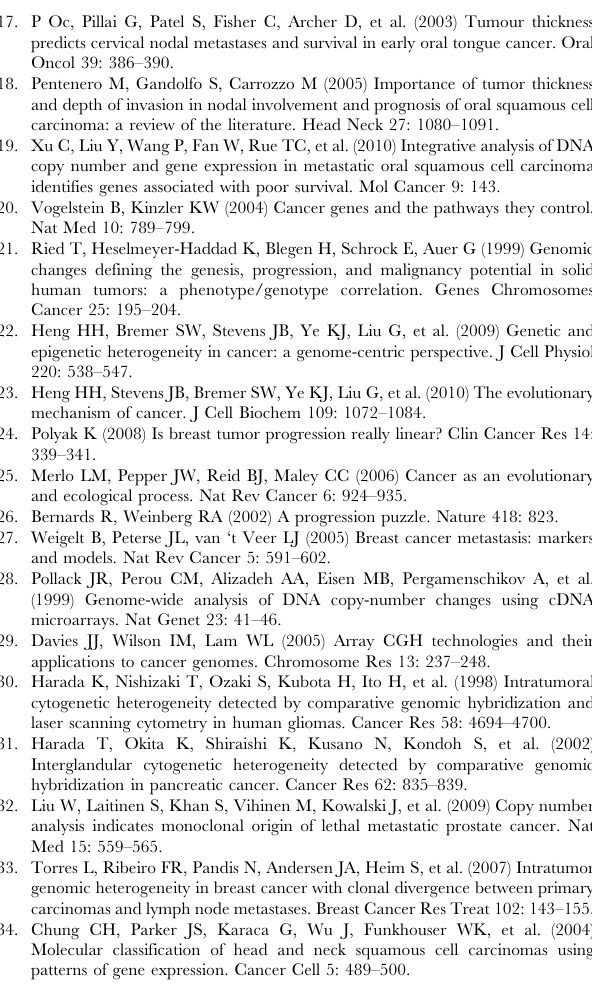
center represent regions of loss. A black arrow indicates a common pattern. A gray arrow indicates a different pattern. (TIF) Figure S5 Whole genomic profiles of the NMPTs from 5 cases. Horizontal lines above the center represent regions of gain, and those below the center represent regions of loss. Figure S6 Whole genomic profiles of the NMPTs from 5 cases. Horizontal lines above the center represent regions of gain, and those below the center represent regions of loss. Figure S7 Genome-wide frequencies of CNAs in 228 OSCCs from Arraymap database website. Frequencies (%) of gains (positive axis) and losses (negative axis) in 228 OSCCs listed in the Arraymap database website, www.arraymap.org, are shown. Table S1 Sample Information. Table S2 All CNAs detected in each sample. (XLSX) Table S3 Quality control metrics of all array samples. (XLSX)